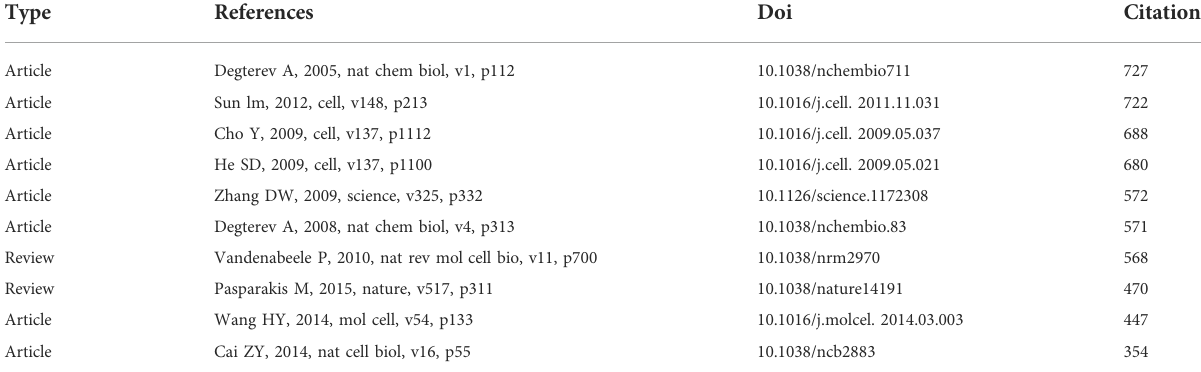
TABLE 4 The top 10 most frequently cited references related to necroptosis research.